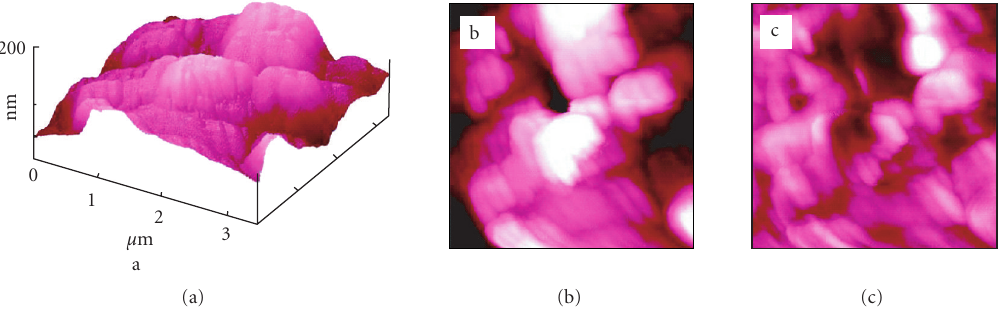
Figure 18: Shear-force AFM (a), (b) and apertureless SNOM (c) of a cryomicrotome cut of a rabbit heart showing lamella structures of mitochondria (bright optical contrast), lamella structures with dark contrast (part of the Golgi apparatus) next to two most brightly reflecting Golgi vesicles (upper part), and a central dark reflection (lysosome).